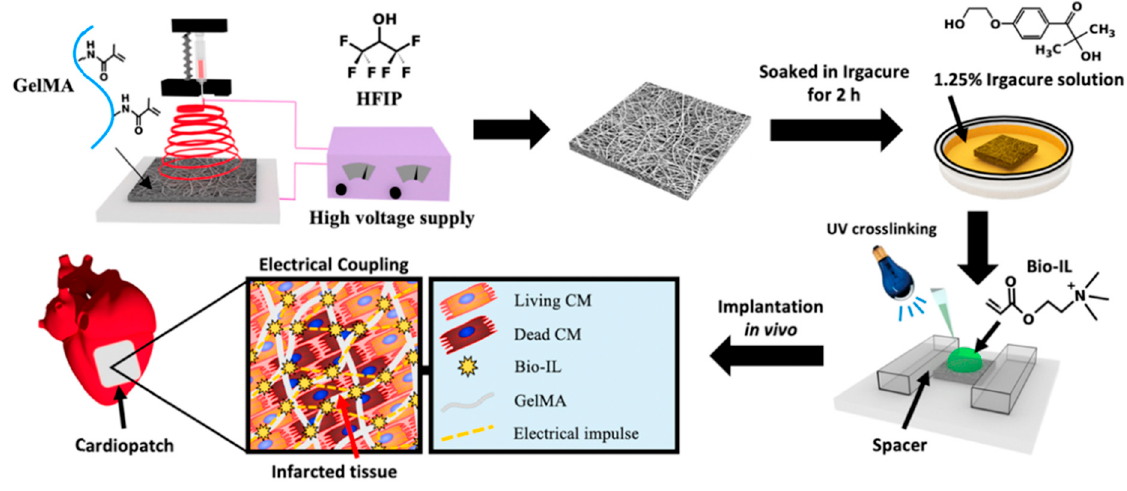
Figure 13. Synthesis and physical properties of electrospun GelMA/Bio-IL cardiopatches. Reproduced with permission from [140].